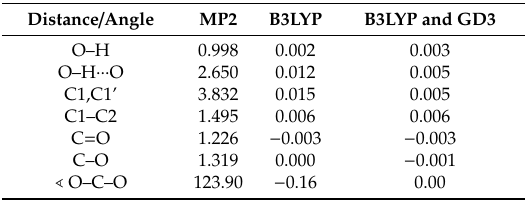
Table 1. Interatomic distances (Å) and the O–C–O valence angle ( (cid:94) , ◦ ) in the cyclic dimer of acetic acid obtained at the second order Møller–Plesset perturbation theory (MP2) level and their di ff erences from the values obtained at the B3LYP level. GD3: Grimme’s dispersion